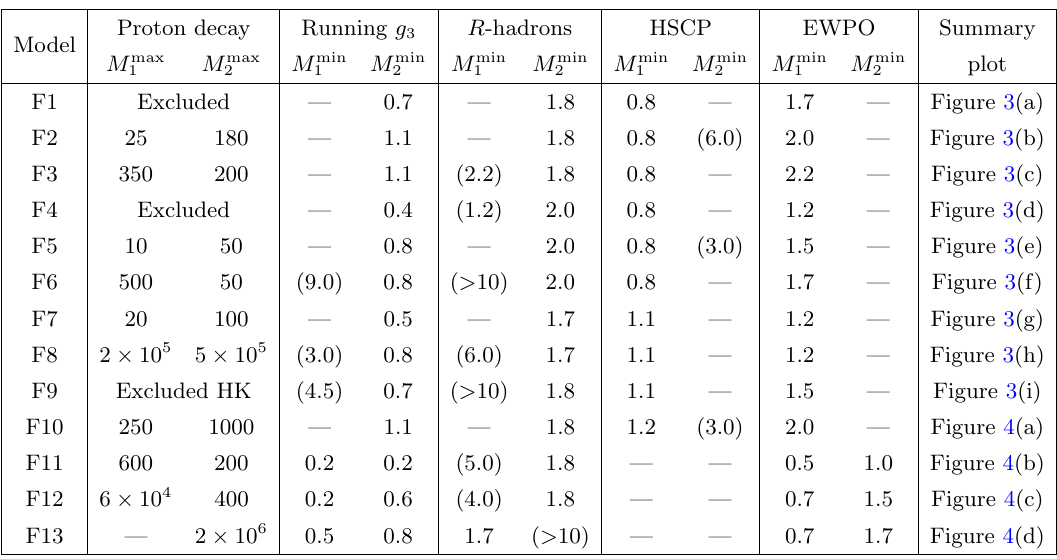
Table 5. Exclusion bounds on the VL masses M 1 and M 2 provided by di(cid:11)erent experiments (all in TeV). In column 2 we indicate the models that are exluded by the measurement of the proton lifetime by Super-Kamiokande [42], as well as the upper bounds provided by the projected Hyper- Kamiokande measurement [43]. In column 3 limits from the running strong coupling constant measurement by CMS [44] are shown. The numbers in parentheses indicate indirect limits whose derivation is described in the text. In columns 4 and 5 bounds from the ATLAS 13 TeV HSCP searches [45] are presented, for colored and non-colored particles, respectively. 100 TeV projections for the EWP tests [46] are shown in column